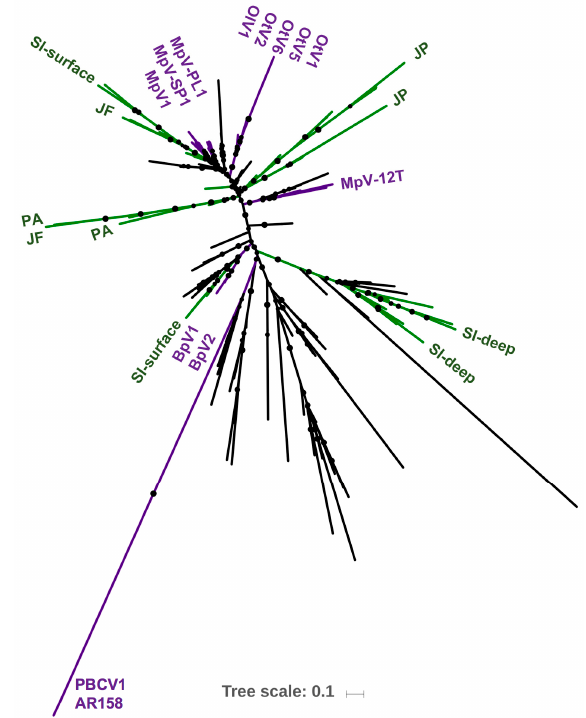
Figure 7. Maximum likelihood tree of 197 partial phycodnavirus DNApol sequences from five environmental samples clustered at 97% aa identity. Reference sequences are highlighted in purple, dominant OTUs and branches for the environmental samples are indicated in green for JP, PA, JF, SI. Black branches represent other operational taxonomic units (OTUs). Bootstrap values indicate branch support, values from 50–100% are shown as size ‐ dependent circles.